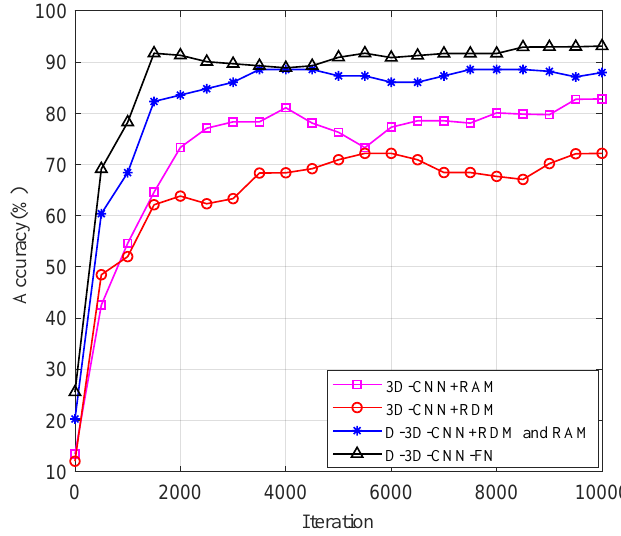
Figure 12. Training process comparison of each